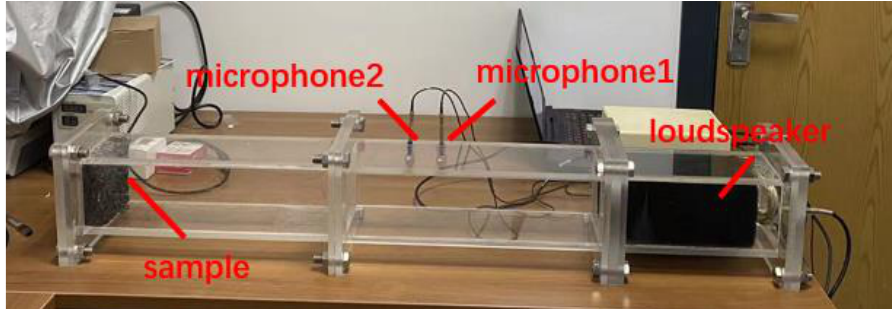
Figure 1. SAC measuring device.